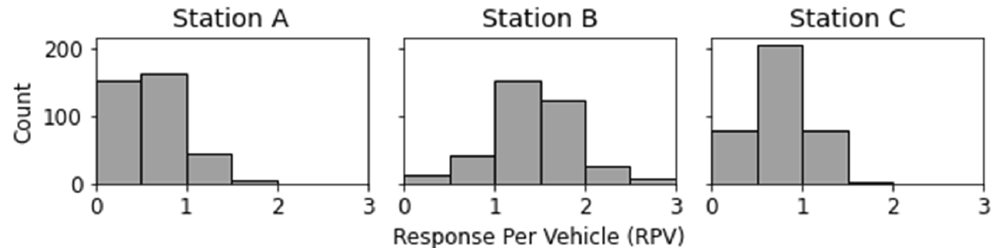
Figure 5. Response per vehicle (RPV) distribution across different days during an arbitrarily chosen time frame for three stations, showing differences in mean and